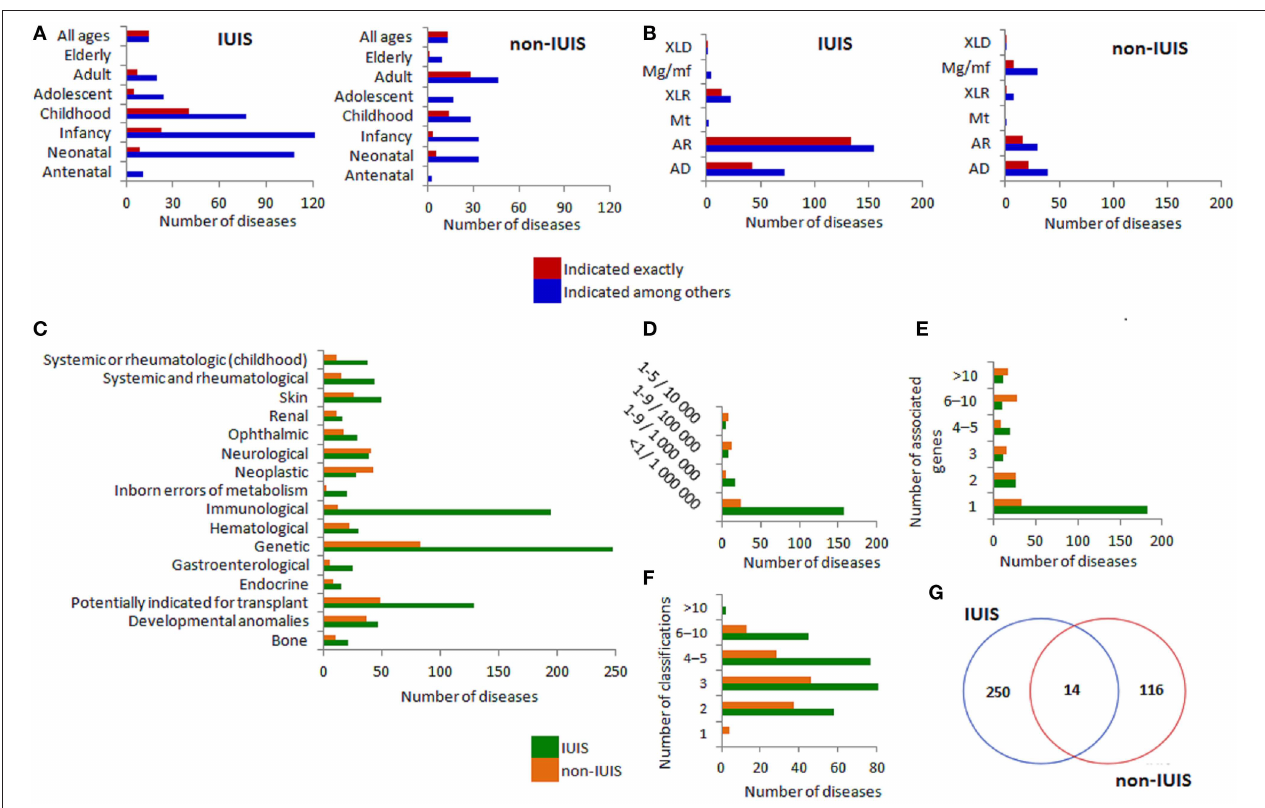
FIGURE 1 | ORPHANET annotations for IUIS/non-IUIS diseases. The distribution of the diseases associated with the IUIS genes by (A) age of onset of the IUIS diseases (left) and non-IUIS diseases (right), (B) mode of inheritance for the IUIS diseases (left) and non-IUIS diseases (right), (C) ORPHANET classifications for rare diseases (classifications including 10 or more diseases are presented), (D) prevalence, (E) number of associated genes, (F) number of classifications per disease, (G) gene-centered Venn diagram for the IUIS- and non-IUIS diseases in the ORPHANET database. (A,B) Since many diseases were associated with more than one gene, we characterized found associations (Y-axis) as indicated among others (different genes are linked to several variants of disease manifestation) and indicated exactly (corresponds to the axis labels). AD, Autosomal dominant; AR, Autosomal recessive; Mt, Mitochondrial inheritance; XLR, X-linked recessive; Mg/mf, Multigenic/mulifactorial; XLD, X-linked